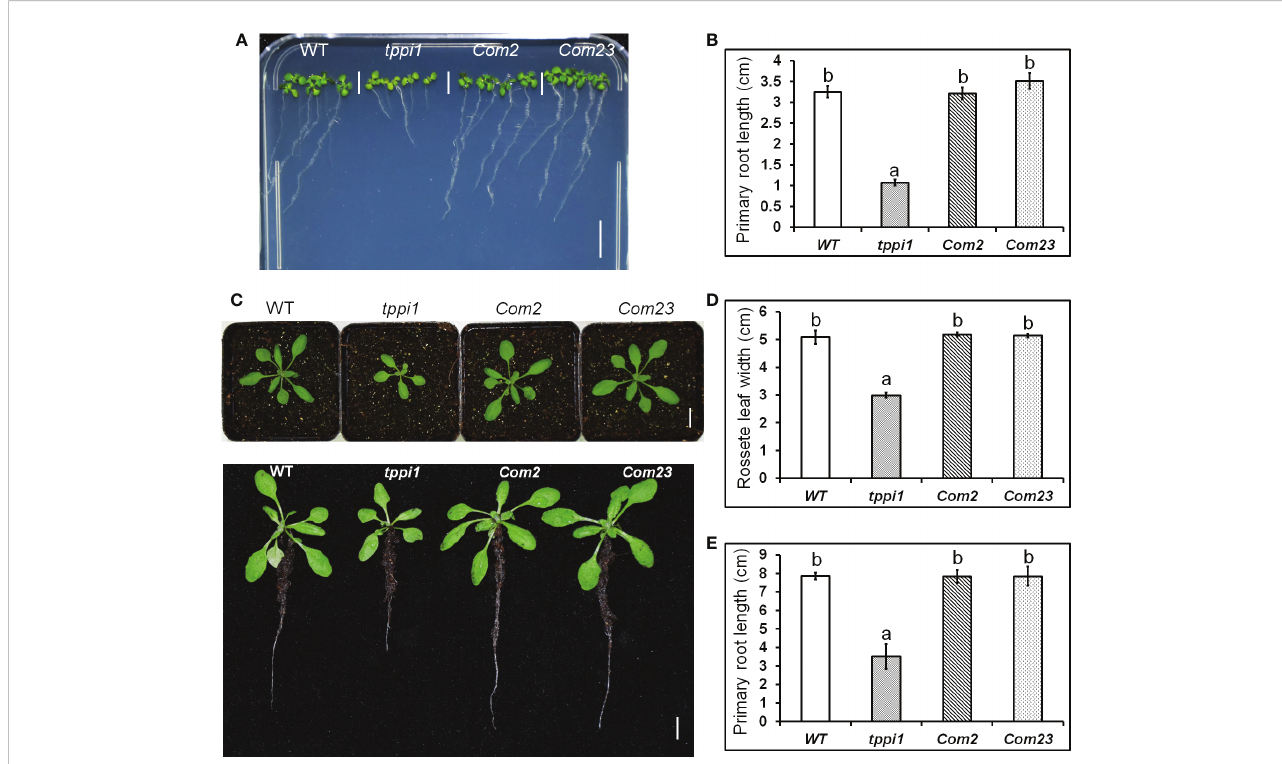
FIGURE 1 AtTPPI can rescue the short primary root of tppi1 mutant. (A) The phenotype of primary root of WT, tppi1 mutant, com2 and com23 on MS vertical medium for two-week days, Bar = 1 cm; (B) The statistical analysis of WT, tppi1 mutant, com2 and com23 on MS vertical medium for two-week days. Three independent experiments were performed. Error bars indicate SEs (n = 3). Different lowercase letters (A, B) indicate signi fi cant differences among lines (Duncan ’ s test; p < 0.05); (C) . The phenotype of primary root of WT, tppi1 mutant, com2 and com23 in 6×6 cm pot in soil, Bar = 1 cm; (D, E) . The statistical analysis of WT, tppi1 mutant, com2 and com23 on rosette leaves size (D) and primary root length (E) . Error bars indicate SEs (n = 3). Different lowercase letters (a, b) indicate signi fi cant differences among lines (Duncan ’ s test; p <